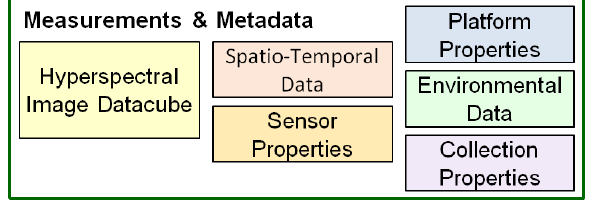
Figure 5 . Conceptual data model for all HSI use